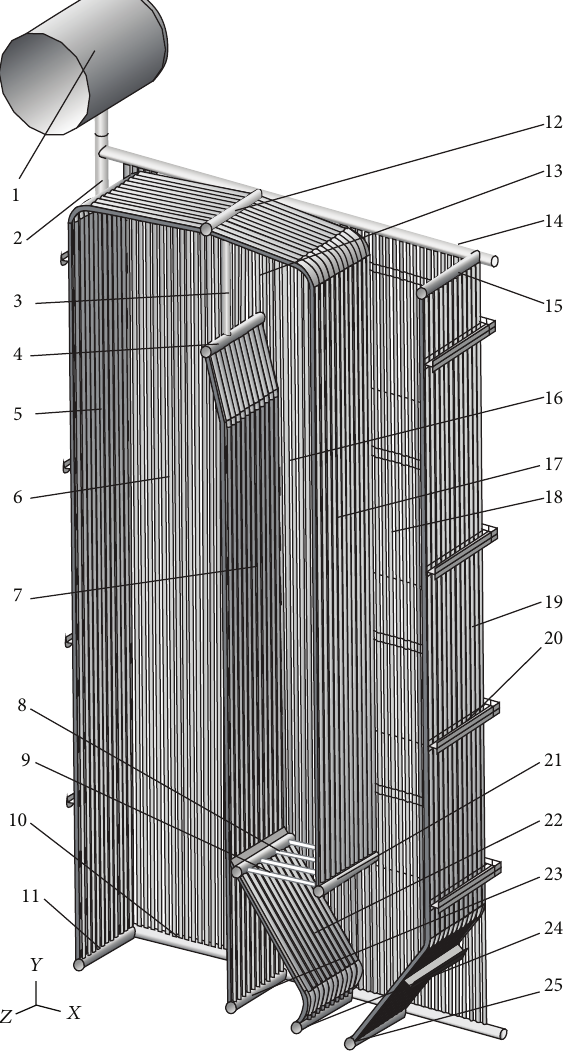
Figure 4: Real calculation geometry